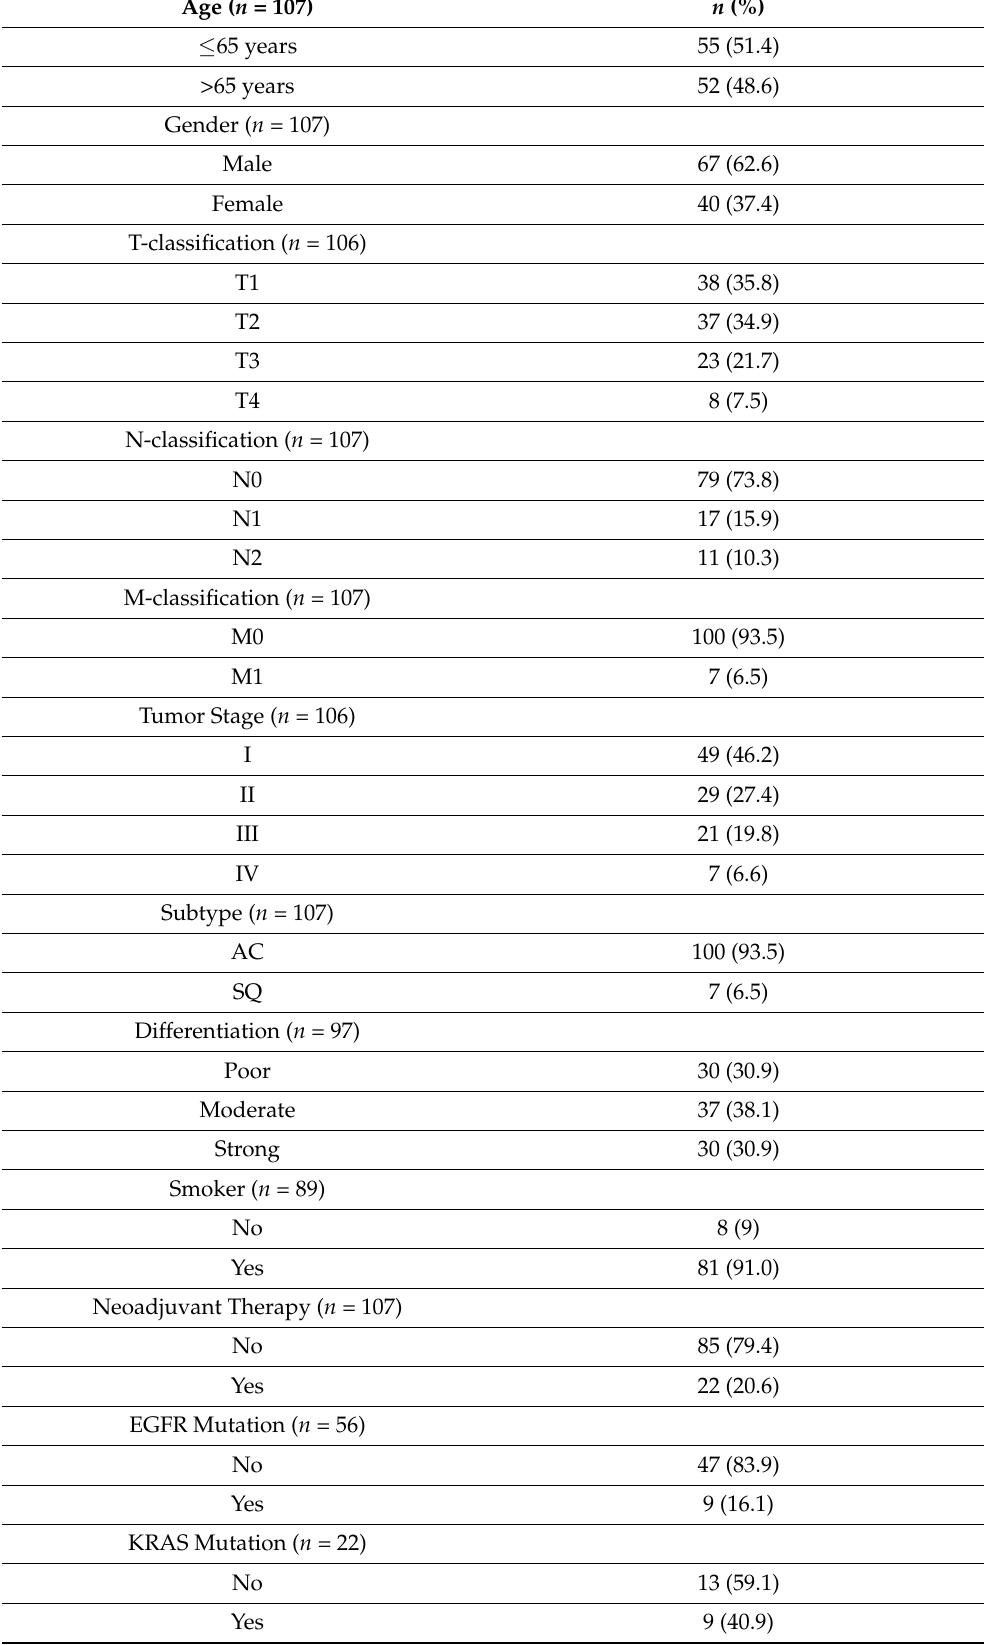
Table 1. Clinicopathological